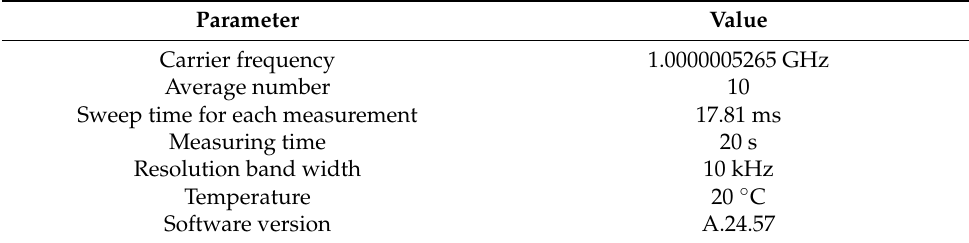
Table 1. N9030A measuring